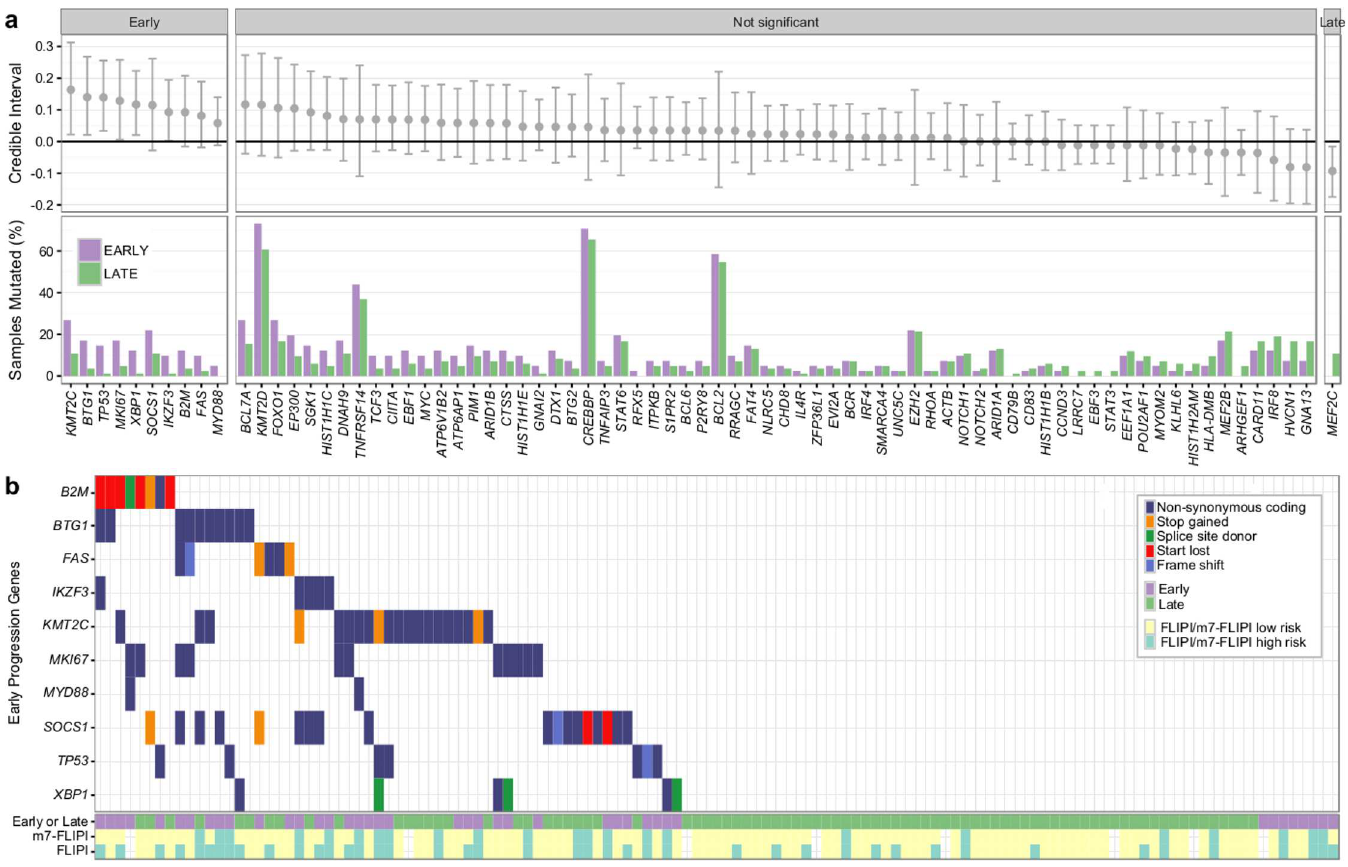
Fig 9. Results from targeted sequencing of 86 genes in 41 patients with early progression and 84 patients with late/never progression. (A) Credibleintervalsfrom Bayesianproportiontest (top). Genes are ranked by group difference and separatedbasedon whetherthe probabilityof a given gene to be more commonly mutated in patients with early progression is > 0.95 or not. The percentage of samples harboringmutations in given genes is given at the bottom. (B) Oncoplot of genes associated with early progression,annotated with FLIPI and m7-FLIPI risk groups. FLIPI, Follicular Lymphoma